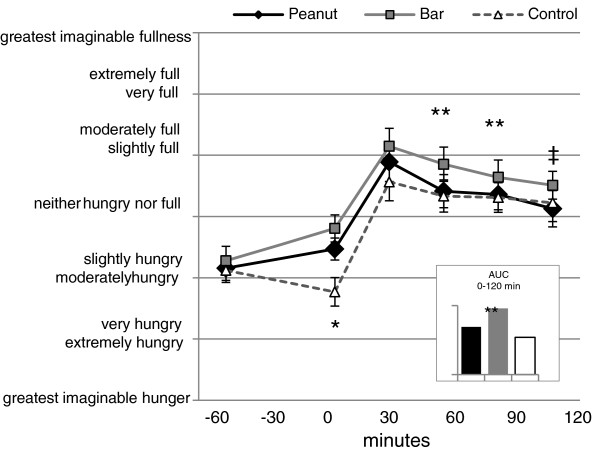
Perceived satiety during the acute trial (mean ± SE; n = 15). At time 0 the test meal was consumed, which was exactly one hour after ingestion of the control treatment (1 c water) or the peanut or grain bar treatments, each with 1 c water. Satiety curves differed significantly (repeated measures ANOVA, time x group interaction; p = 0.002). The area-under-curve for 0–120 minutes differed by treatment (see inset; p = 0.003). * satiety for control treatment significantly less than that for peanut or grain bar (p < 0.05). ** satiety for grain bar significantly greater than that for peanut or grain bar (p < 0.05). ‡ satiety for grain bar significantly greater than that for peanut (p = 0.023).